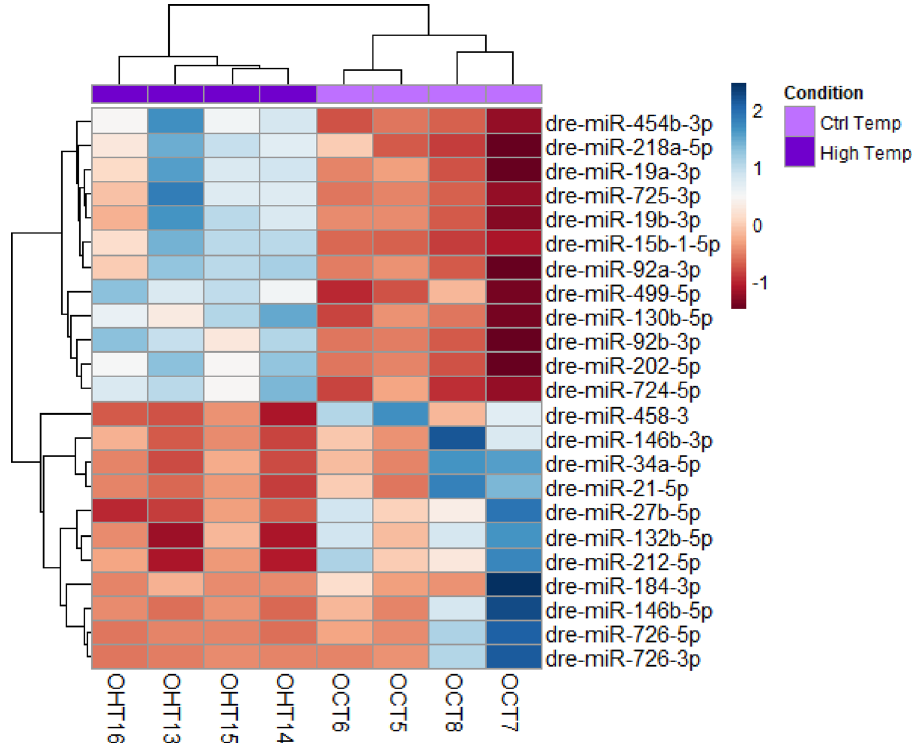
Figure 2. Heatmap of 23 differentially expressed (DE) miRNAs in mature ovaries after exposing zebrafish to high temperature during sex differentiation. The color scale ranges from blue to red, where blue shows relative overexpression and red is relative under expression. Both miRNAs and samples were grouped by hierarchical